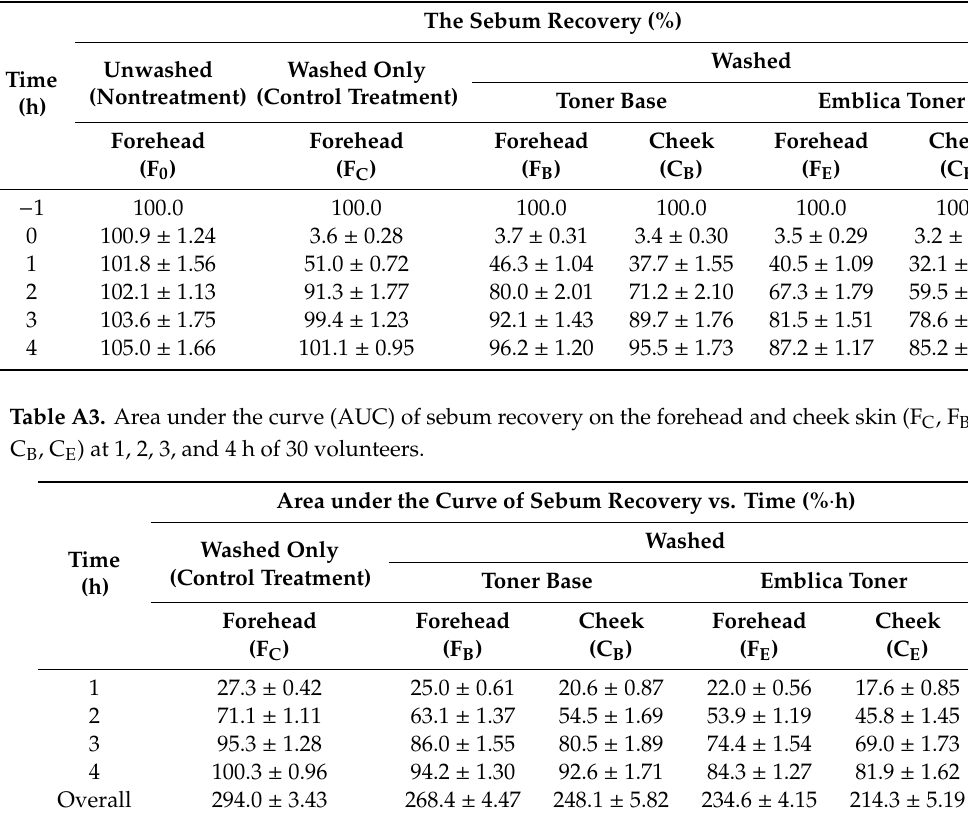
Table A2. The sebum recovery on the forehead and cheek skin (F C , F B , F E , C B , C E ) at 1, 2, 3, and 4 h of 30 volunteers (from Equation (1)).